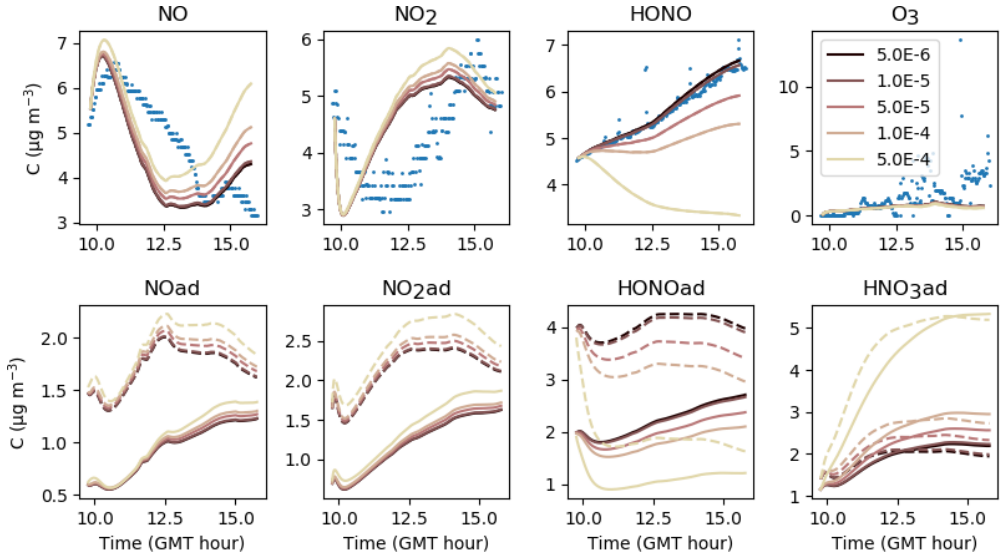
Figure 15. Gas-phase and adsorbed inorganic compounds simulated for different k S3 . The blue dots denote the experimental measurements (Experiment 2). The solid lines represent the concentrations in the sunlit box and the dashed lines the concentrations in the shaded